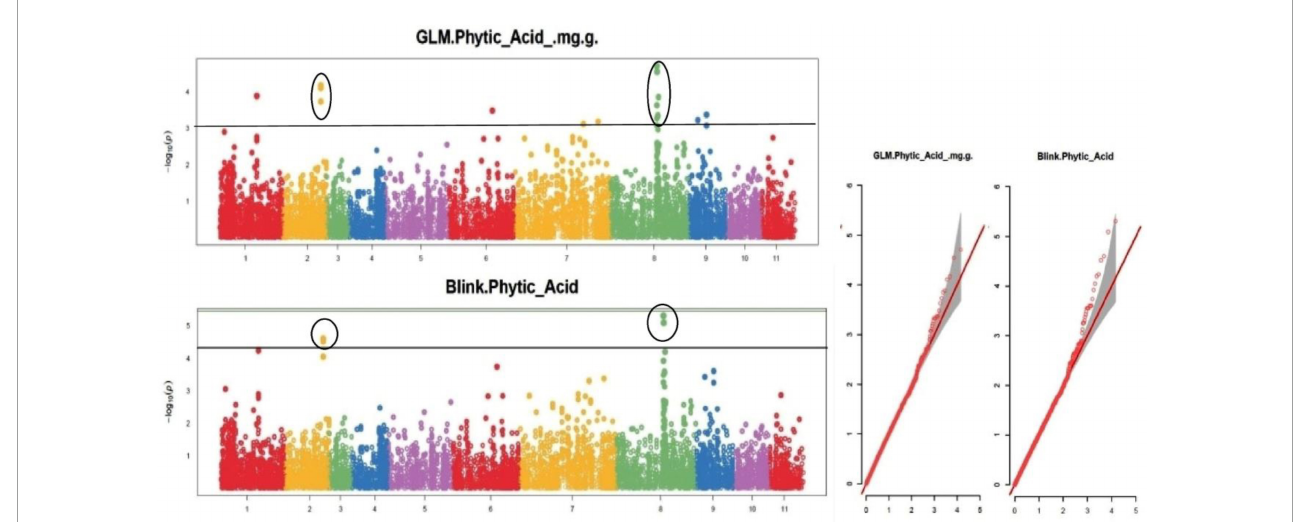
FIGURE8 Manhattan plots and Quantile-Quantile plots depicting the significant association of SNP markers with grain phytic acid content.